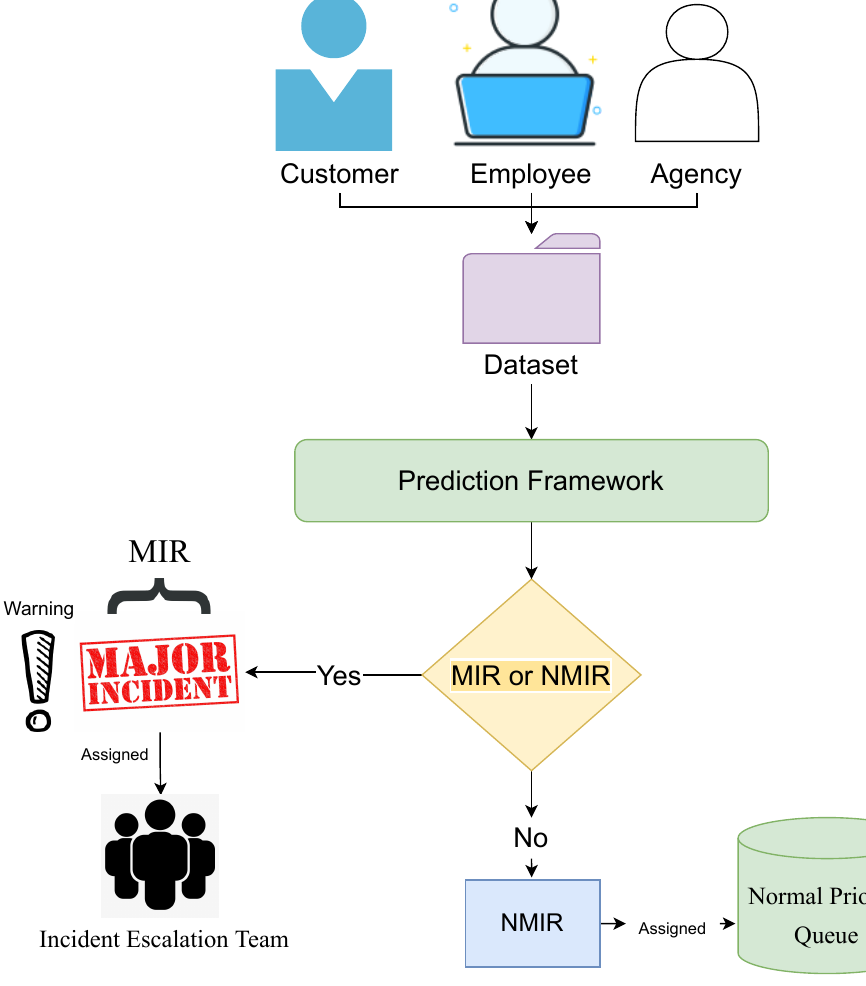
Figure 3. Proposed IT incident risk